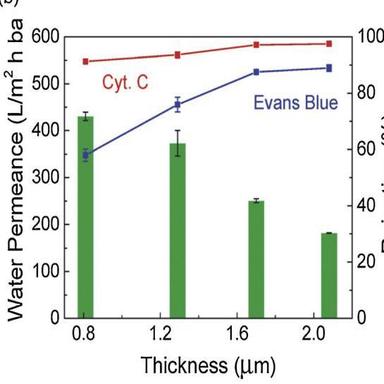
(a) Cross-section and (c) high-magnification cross-sectional SEM images of a MoS2 membrane with a thickness of 1.7 mm +/- 60 nm; (b) water flux and rejection rates of Evans Blue and Cytochrome C through the MoS2 membrane (For interpretation of the references to colour in this figure legend, the reader is referred to the web version of this article.).